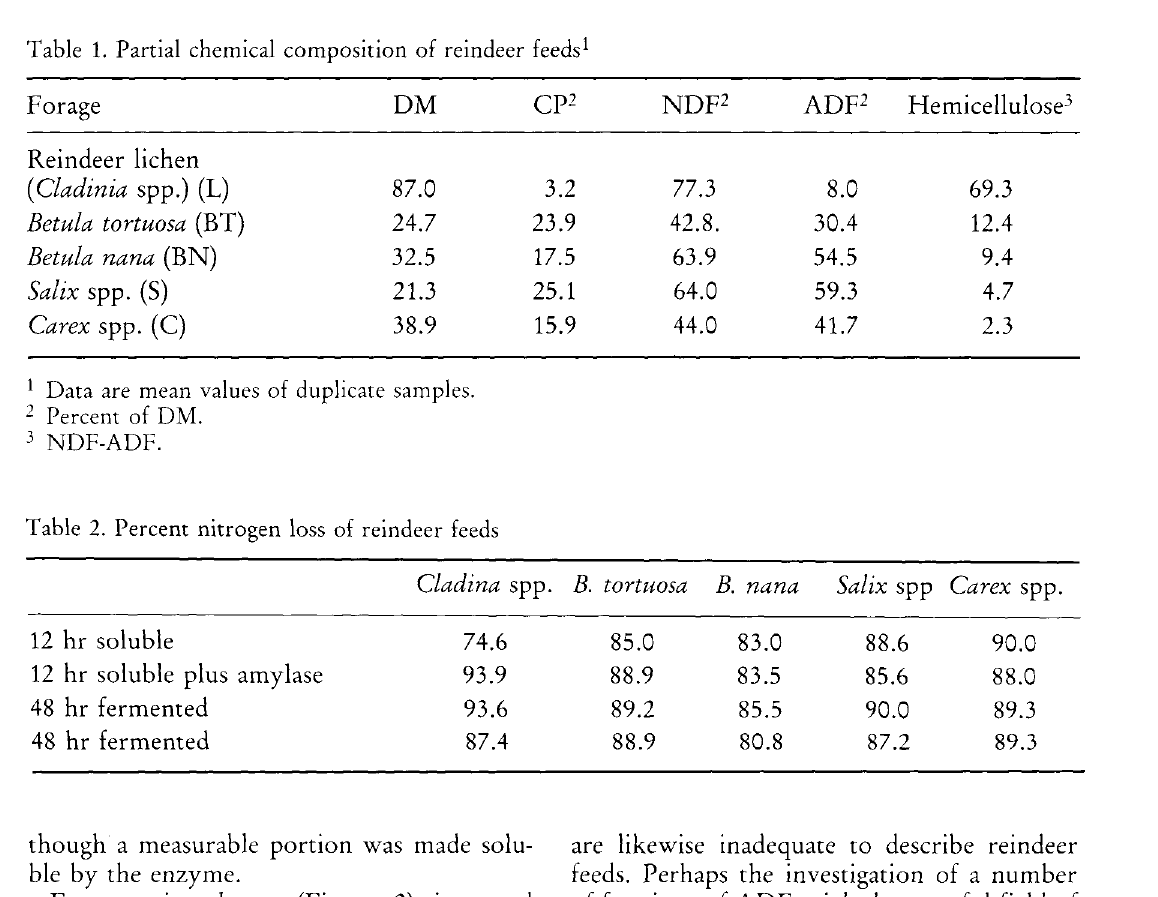
Table 1. Partial chemical composition of reindeer feeds 1